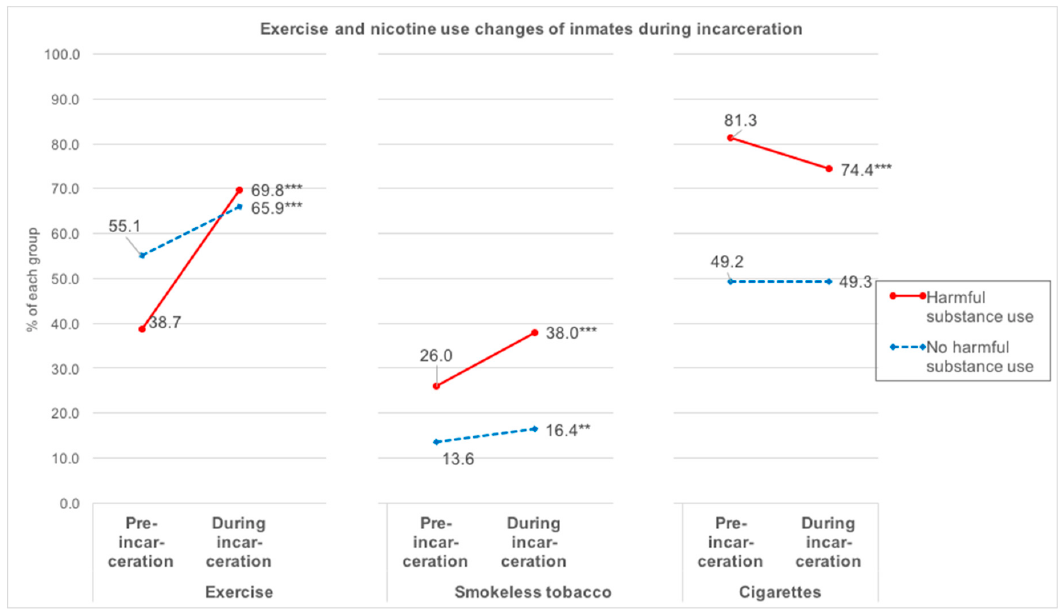
Figure 2. Exercise and nicotine use changes of inmates during incarceration. Within-group differences over time indicated by: * p < 0.05, ** p < 0.01, *** p < 0.001.